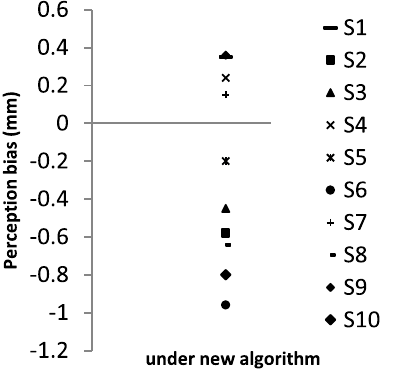
Fig. 10. Results of Exp. 3. Individual biases under new algorithm.